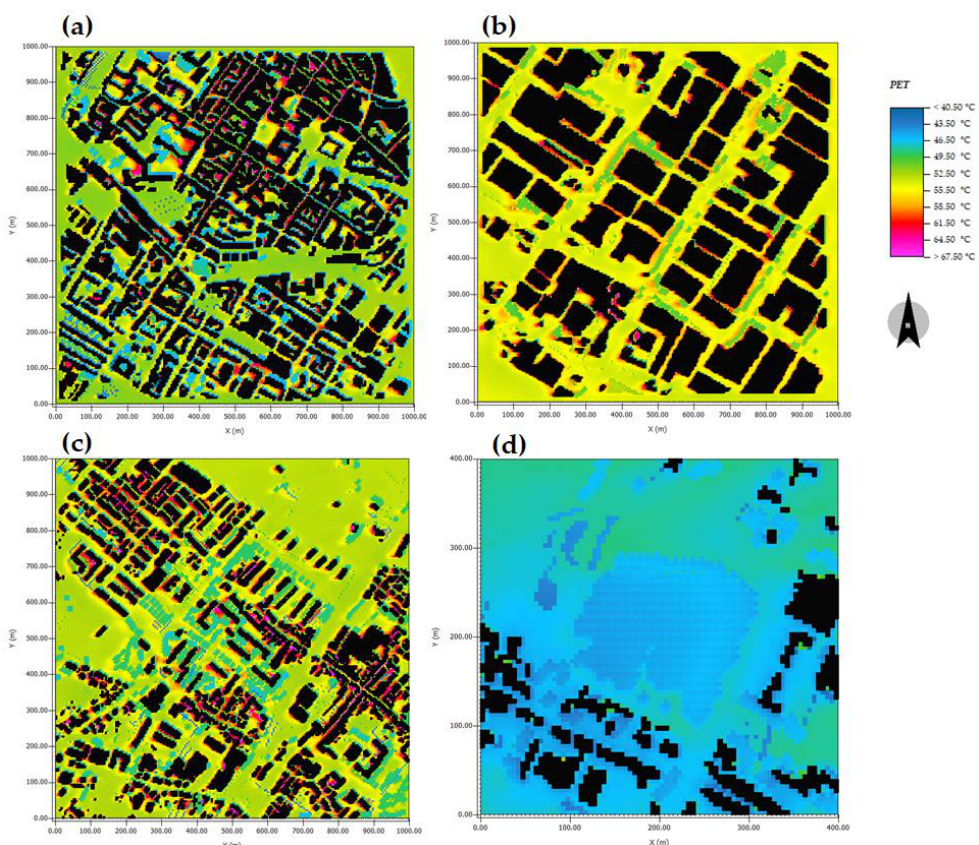
Figure 6. 1.8 m height PET at h 14:00 modelled with Envi-met software for the four test areas: ( a ) historical center; ( b ) industrial area; ( c ) residential area; ( d ) green area.